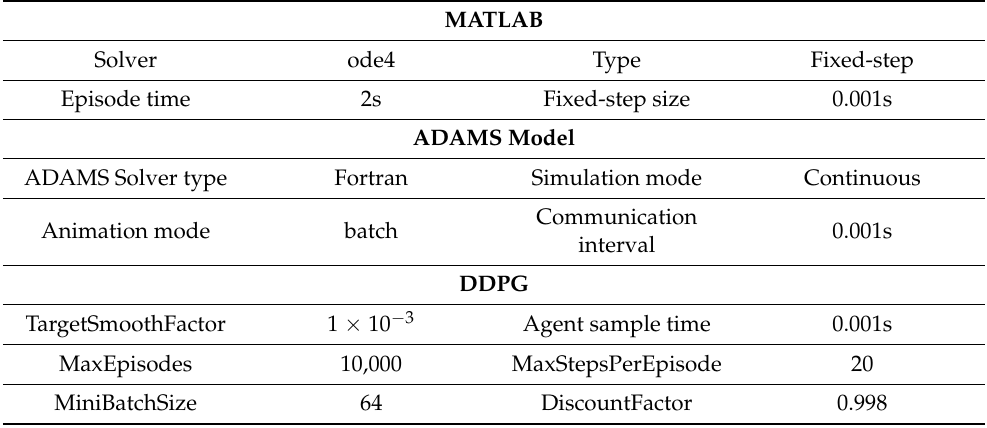
Table 1. Specifications of